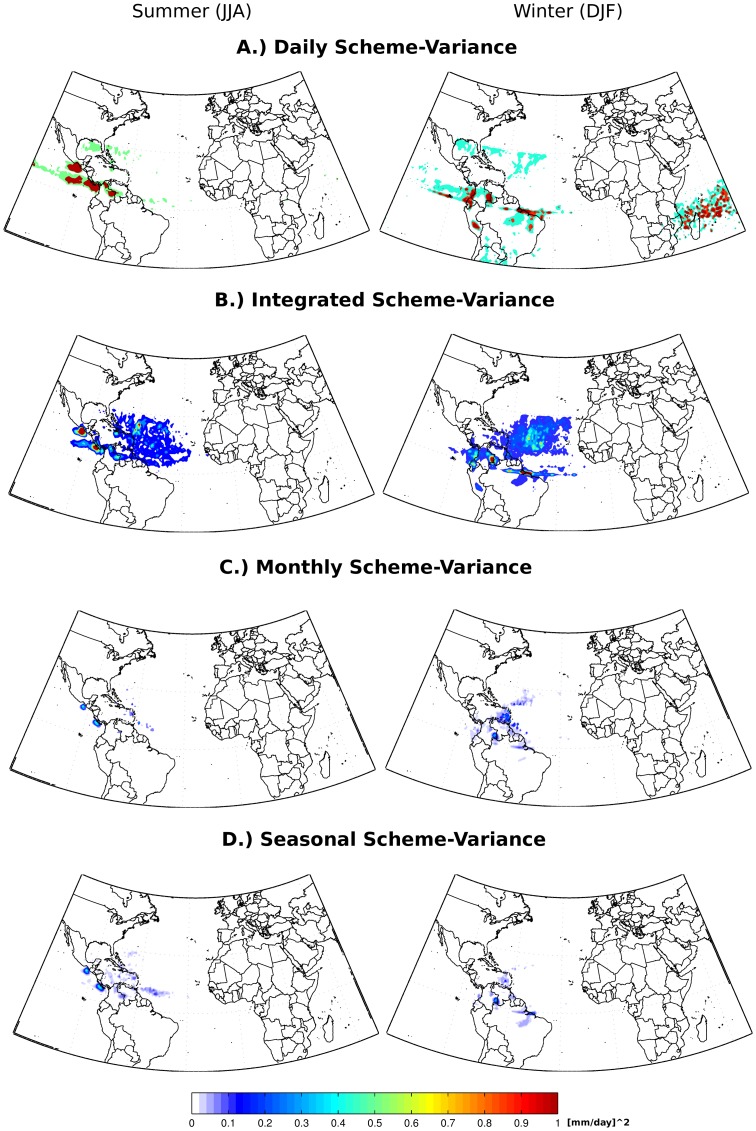
As for
Figure 3
, but for interannual variance of net precipitation (E-P<0).